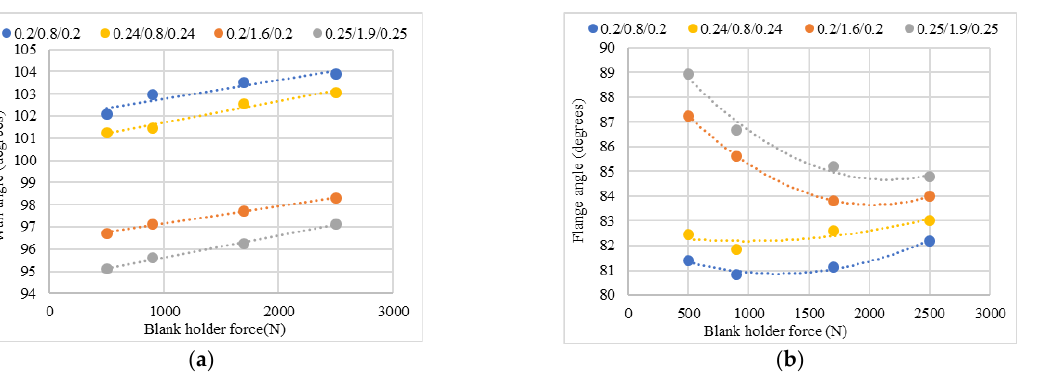
Figure 17. ( a ) Effect of BHF on wall angle ( b ) Effect of BHF on flange angle for various thickness combinations of sandwich laminates.